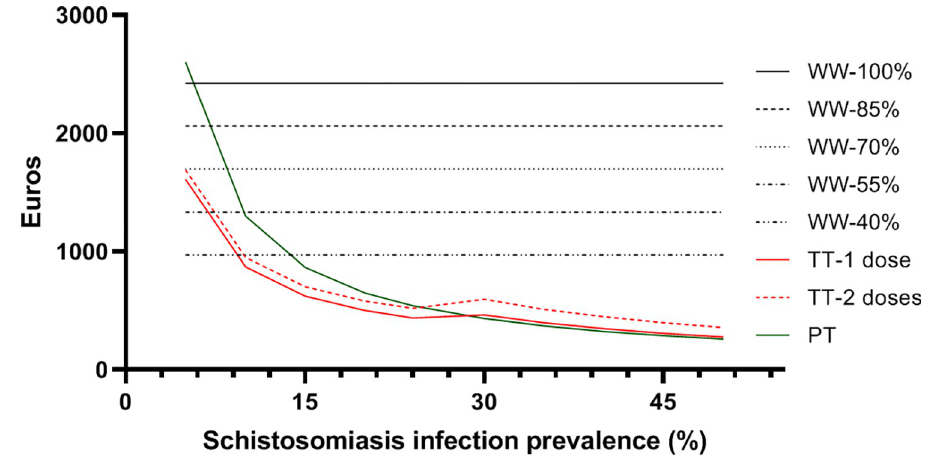
Fig 2. Projected cost per infected individual for each strategy at different prevalence rates and for the WW strategy, at five percentages of the maximum cost of treatment of associated morbidities * . * WW: Watchful and waiting strategy; PT: Presumptive treatment; TT: Test and treat